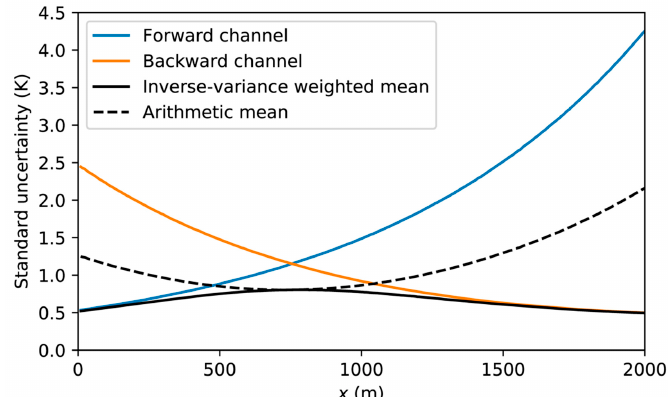
Figure 6. Synthetic example of the standard uncertainty of the estimated temperature using arithmetic mean and the inverse-variance weighted mean (2). Final sentence of Section 10.1 should be changed from “The standard uncertainty of the inverse-variance weighted mean is shown with the solid black line and is much smaller along the entire fiber” to "The standard uncertainty of the inverse- variance weighted mean is shown with the solid black line and is much smaller near the ends of the fiber. The standard uncertainty of the inverse-variance weighted mean is equal to that of the arithmetic mean where the standard uncertainty of the forward-channel measurements is equal to that of the backward-channel measurements.”